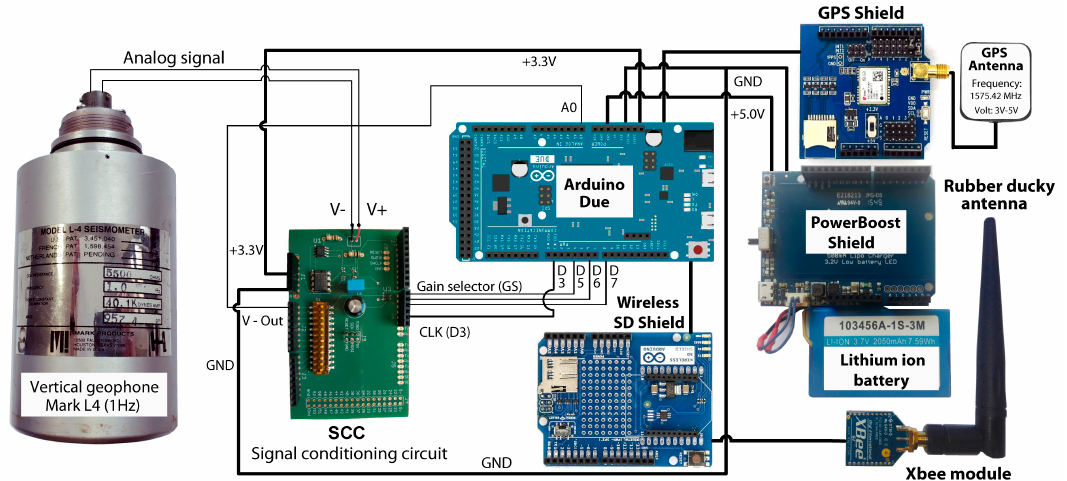
Figure 2. Diagram of the components and connections of the Acquisition Control Node (ACN) system.